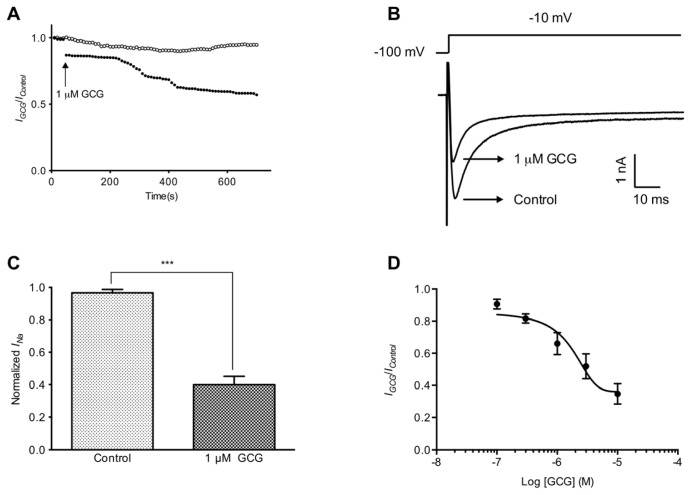
GCG-induced inhibitory effect on tetrodotoxin-resistant Na+ currents in rat dorsal root ganglia (DRG) neurons. (A) Example time courses of tetrodotoxin-resistant Na+ current in the absence (unfilled circles) and presence of 1 μM GCG (filled circles); (B) Representative tetrodotoxin-resistant Na+ currents in rat DRG neurons; (C) The blockade of tetrodotoxin-resistant Na+ currents after treatment with 1 μM GCG for 5 min (n = 6); (D) Concentration-response curve of tetrodotoxin-resistant Na+ currents inhibition by GCG (n = 4).